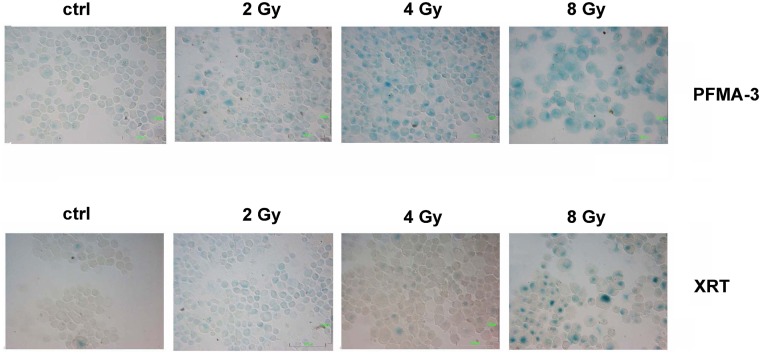
PFMA-3 caused higher levels of SIPS respect to XRT.Representative images of staining for senescence-associated β-galactosidase 96 hrs following irradiation with 2, 4 and 8 Gy PFMA-3 and XRT. Data were representative of three independent experiments. ctrl, control cells.